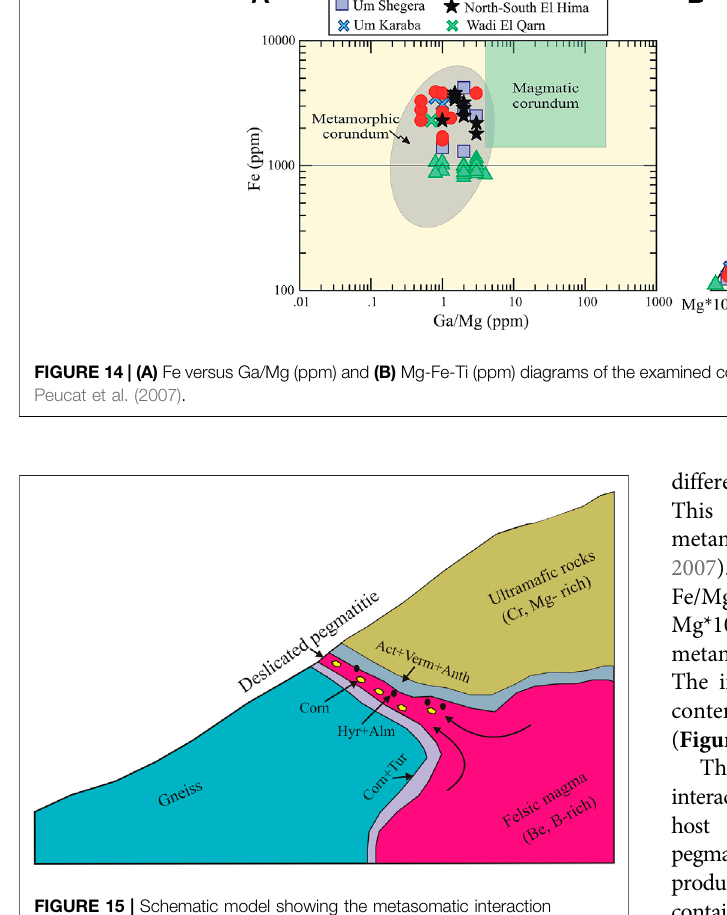
( Figure 14A ). Further constraints, Fe/Mg ratio is used to